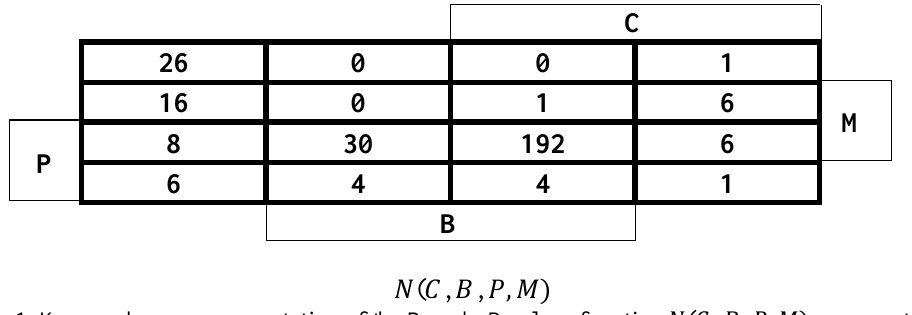
Fig. 1. Karnaugh-map representation of the Pseudo-Boolean function 𝑁 ( 𝐶 , 𝐵 , 𝑃, 𝑀) representing the numbers of cases observed by Rushdi (2017) in various